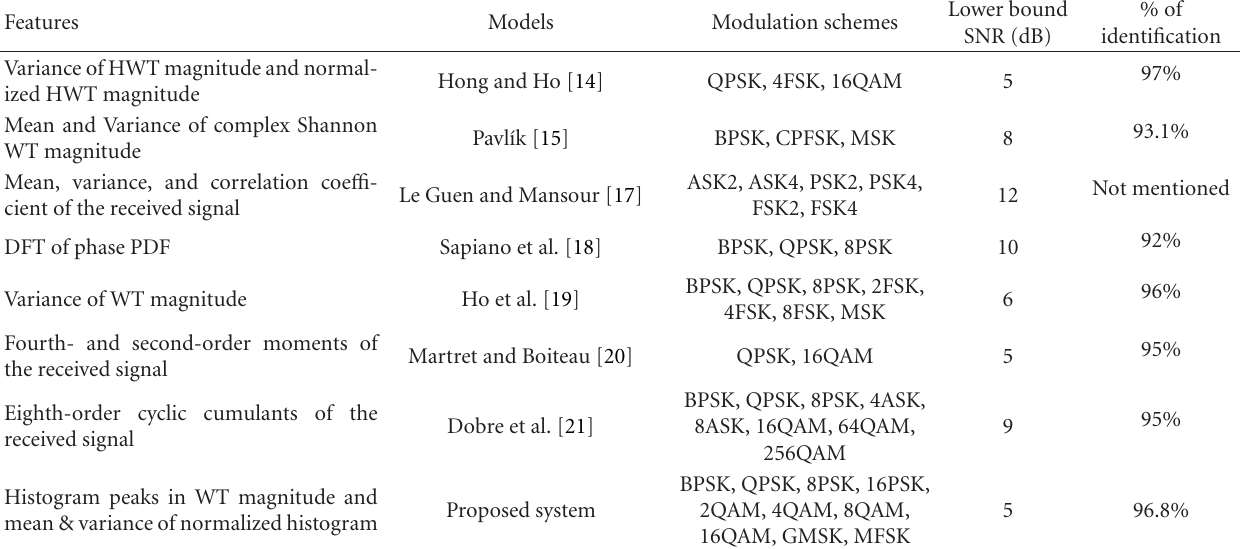
Table 5: Comparison of proposed system with existing